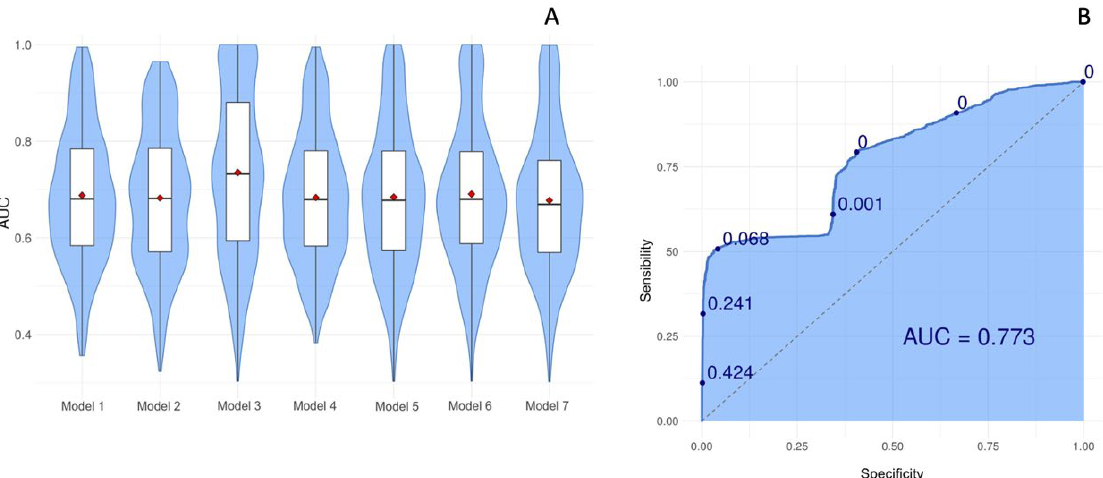
Figure 3. AUC calculated according to the model adjusted by logistic regression. ( A ) Model 3 pre- sents a superior AUC, therefore obtained the best performance in this comparison. ( B ) The graph represents AUC calculated for Model 3, based on sensitivity and specificity